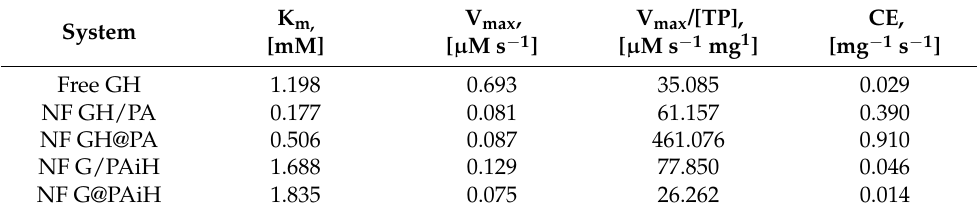
Table 2. Kinetic parameters of the bienzyme PANF complexes extracted from the Michaelis-Menten equation by the double reciprocal Lineweaver-Burk plot. Data for the free GOx/HRP are presented for